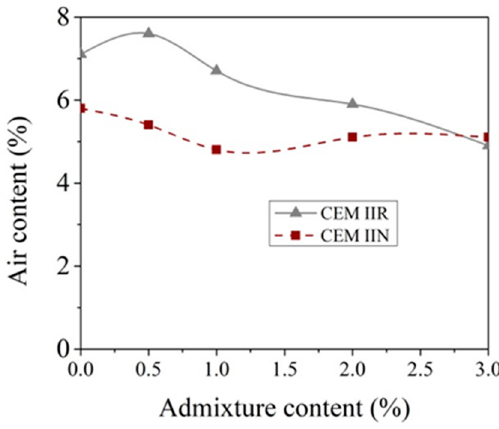
Figure 8. Entrained air content in concrete with CEM IIR and with CEM IIN dependence of CN content (0 h–measured after mixing, 1 h–measured after 1 h).